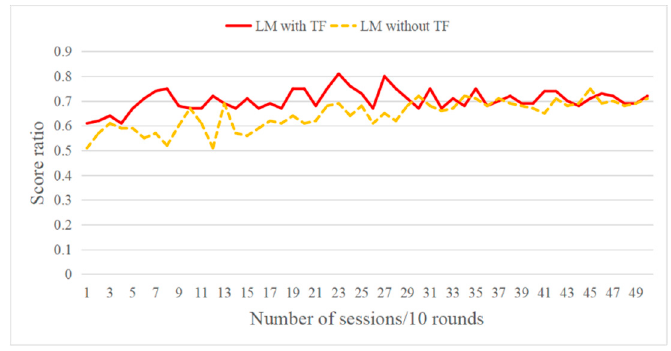
Figure 16. Comparisons of learning models in score ratio. One model uses transfer learning, the other does not use transfer learning.